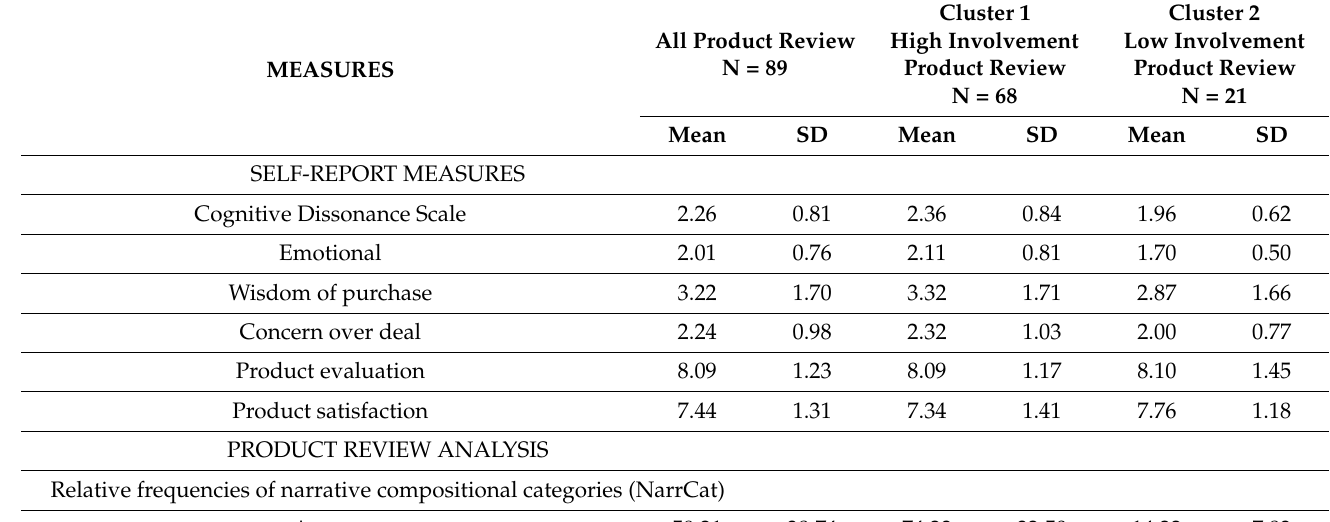
Table 3. Descriptive statistics of the self-report measures and relative frequencies from the product review